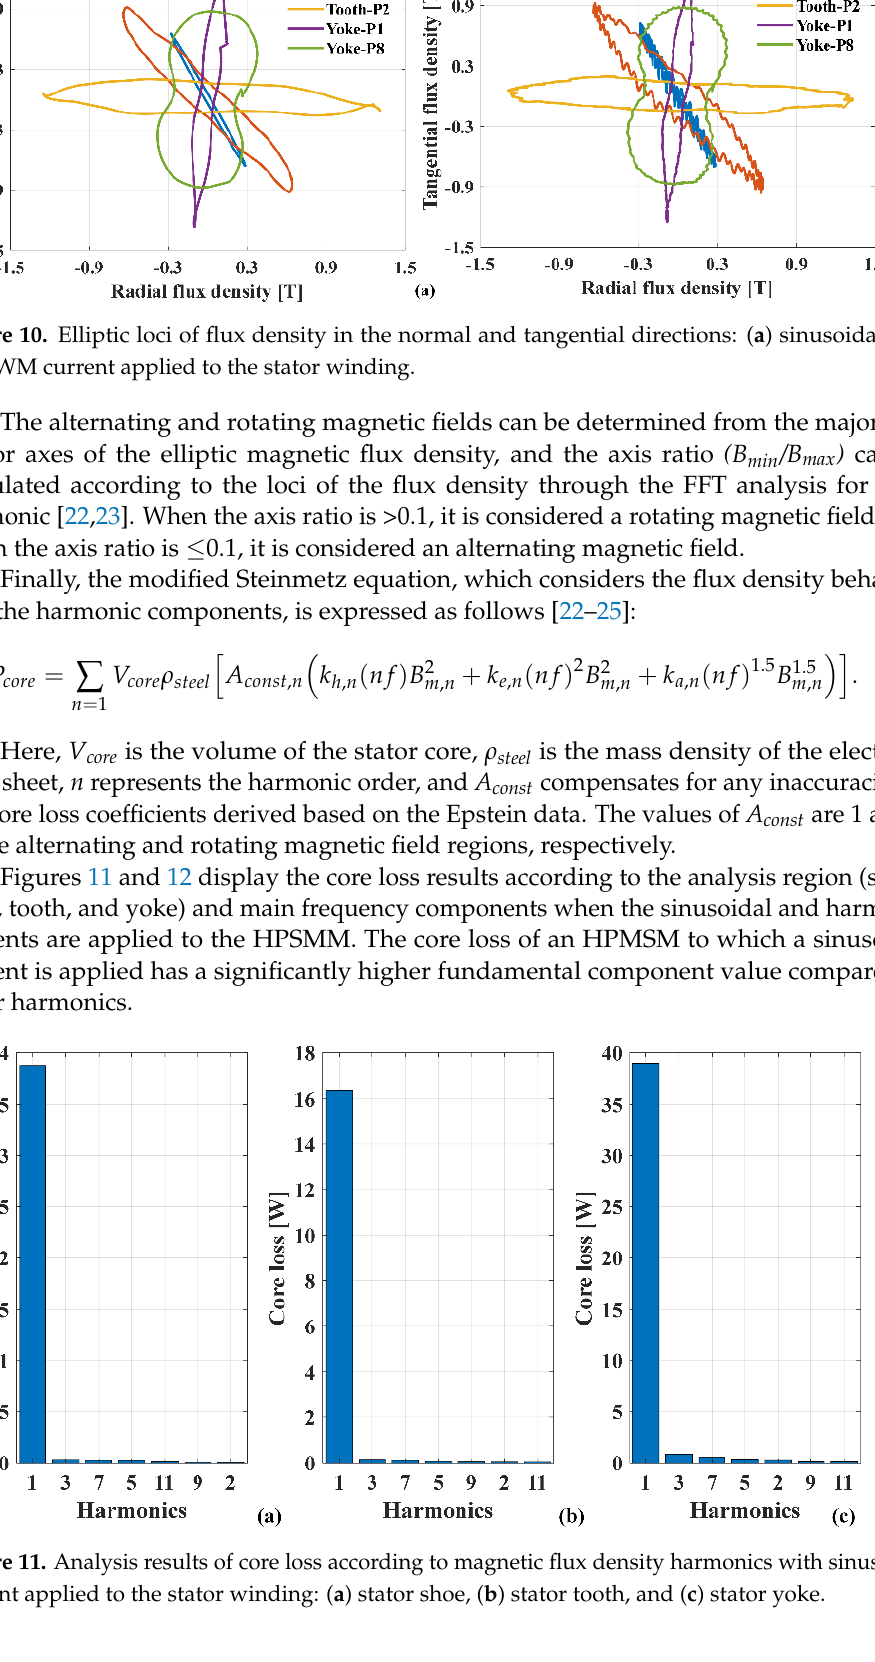
Figure 12. Analysis results of core loss according to magnetic flux density harmonics with PWM current applied to the stator winding: ( a ) stator shoe, ( b ) stator tooth, and ( c ) stator yoke. When the harmonic current is applied to an HPMSM, the fundamental current com- ponent and the 27th, 57th, 58th, and 59th orders included in the current harmonic cause significant core losses in each region. Moreover, from the analysis results, the electromag- netic losses (including stator copper losses, core losses, and rotor eddy current losses) in- crease significantly when the harmonic current is applied to HPMSMs. 4. Experimental Setup and Performance Evaluation To verify the proposed analysis method, a back-to-back experimental setup was con- structed using manufactured HPMSMs and an inverter, load generator and load resistors, speed and torque sensors, an oscilloscope, and a power analyzer. In particular, to measure the mechanical losses, a rotor with a magnetized PM and a rotor with a non-magnetized PM were manufactured and assembled with a stator.